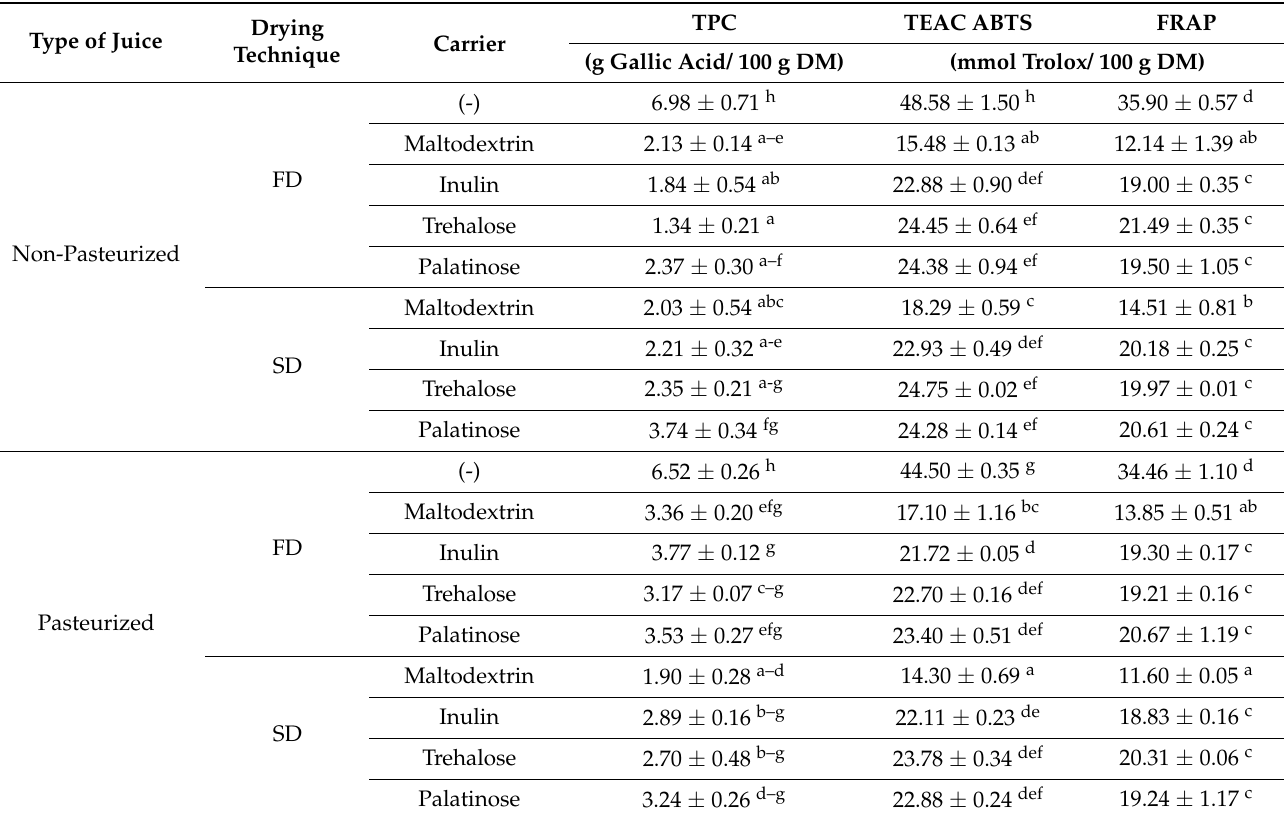
Table 4. The total phenolic content (TPC), antioxidant capacity measured by TEAC ABTS and FRAP methods in rosehip juice powders obtained after freeze- and spray drying ( n = 2; average ± standard deviation). (-)—no carrier addition, FD—freeze-drying, SD—spray drying, DM—dry matter; a,b,c,d,e,f,g —the same letters within a column indicated no statistically significant differences (HSD Tukey test; p ≤